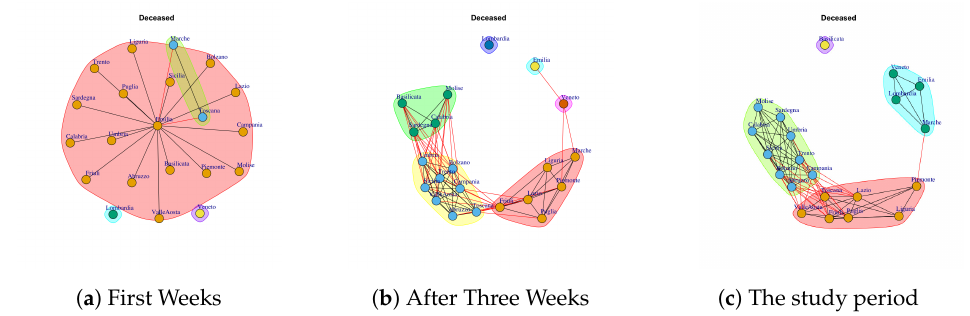
Figure 21. Evolution of Deceased Network Communities.